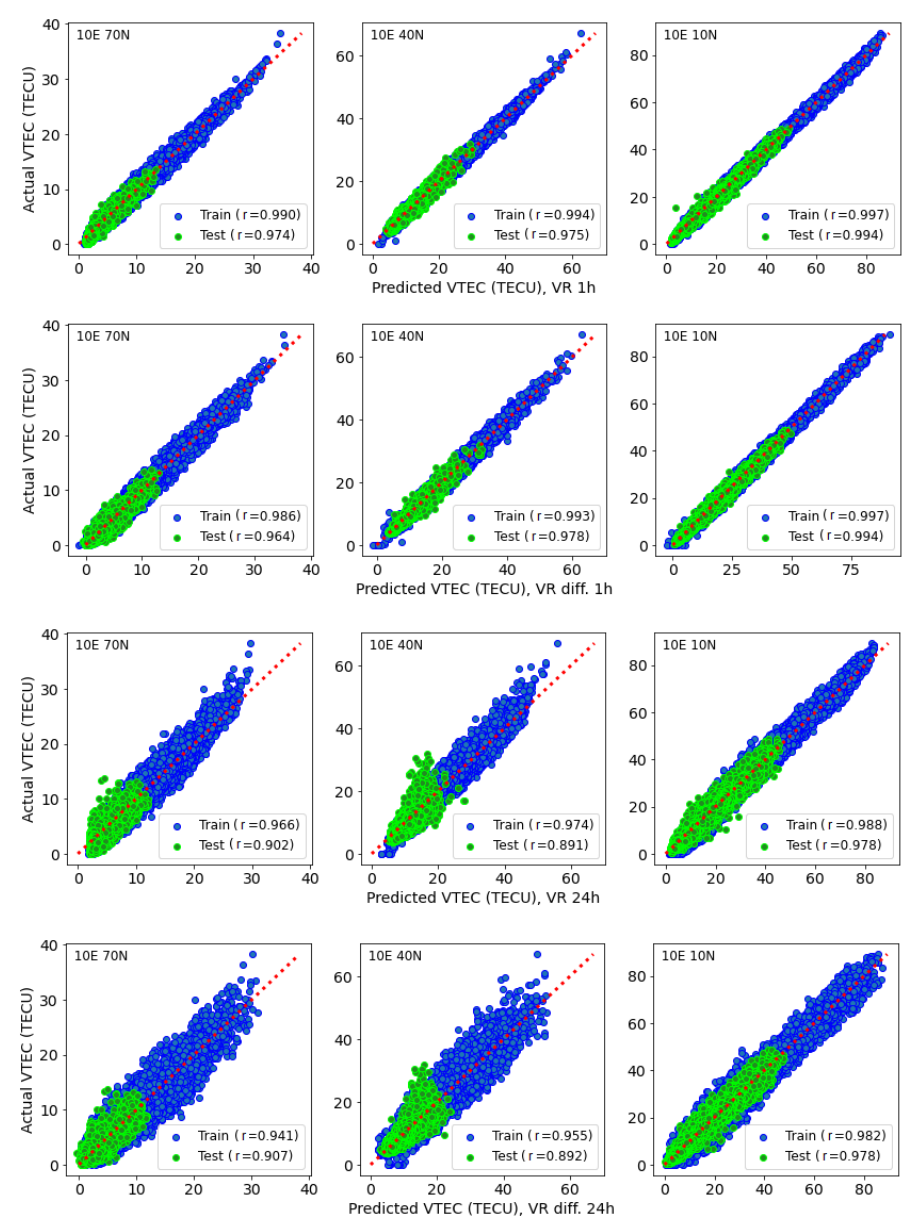
Figure 17. Predicted VTEC by the VR1 models vs. ground truth VTEC for training and cross- validation (blue) and test (green) datasets. First row : 1 h forecast with non-differenced data, second row : 1 h forecast with differenced data, third row : 24 h forecast with non-differenced data, fourth row : 24 h forecast with differenced data for high-latitude ( left ), mid-latitude ( middle ) and low-latitude ( right ) VTEC grid